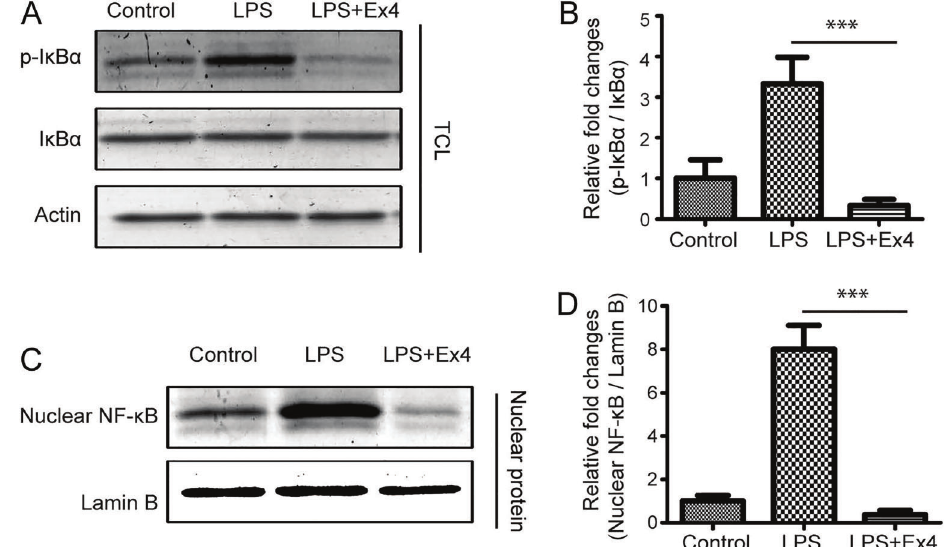
Figure 6. Effect of exendin-4 (Ex4) on lipopolysaccharide (LPS)-activated NF- k B pathway in mouse peritoneal macrophage. Mouse peritoneal macrophages were treated with LPS or a combination of LPS and Ex4 for 30 min. Western blot image ( A ) and quanti fi cation ( B ) of basal protein and phosphorylation levels of I k B a . Western blot image ( C) and quanti fi cation ( D ) of NF- k B protein level in nuclei. TCL: total cell lysate. The results are representative of three independent experiments. Data are reported as means ± SD. ***P o 0.001